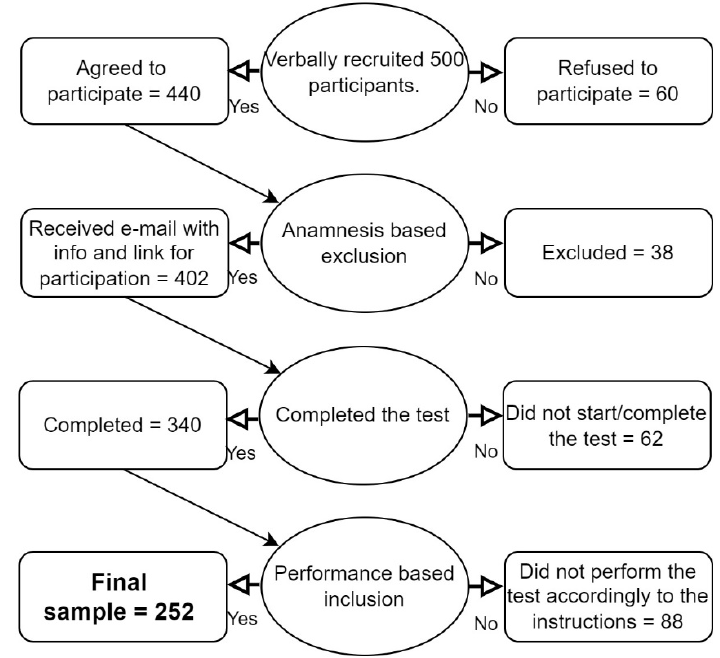
Figure 1. Diagram of participants’ recruitment.